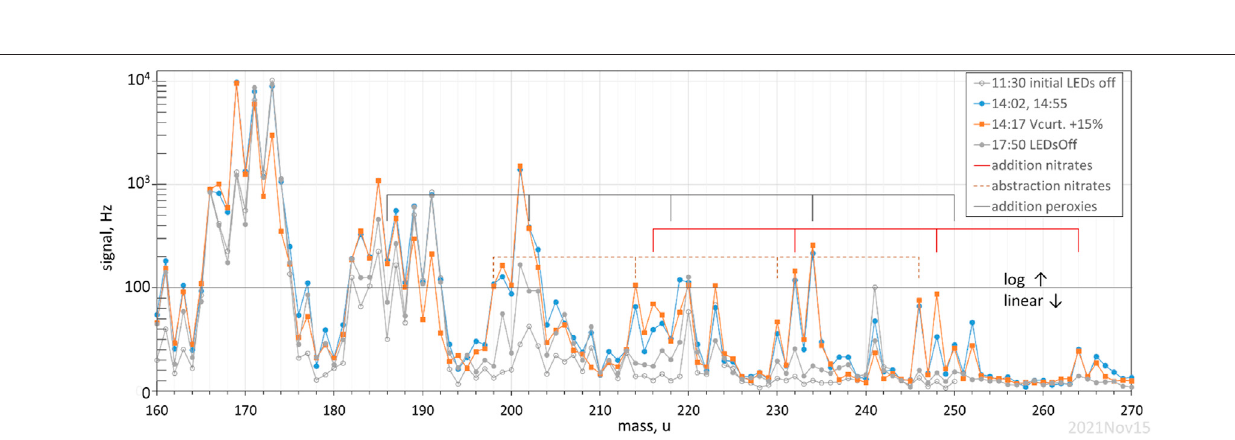
Frontiers in Environmental Science |